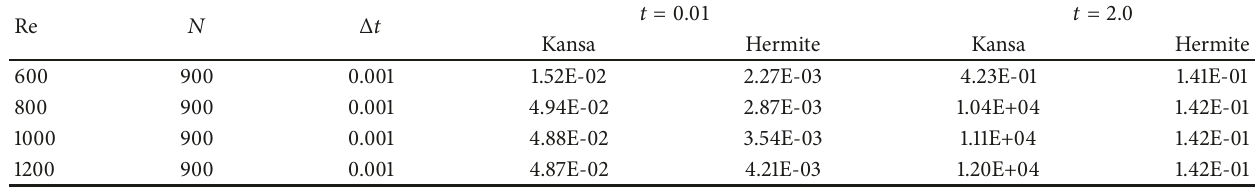
Table 6: Averaged 𝐿 𝑟𝑚𝑠 - error obtained with 𝜀 = 0.001 for moderate to high Reynolds number.